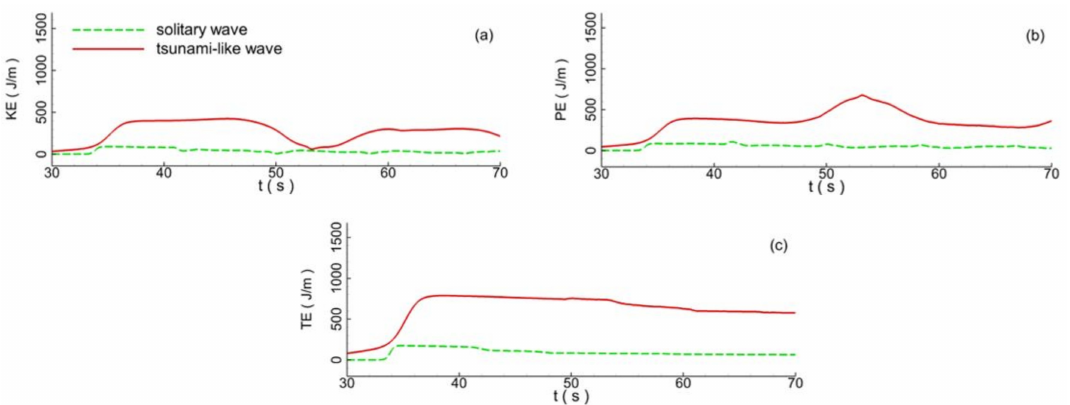
Figure 15. Comparisons of the temporal evolutions of wave energies of the whole water body in the computational domain; ( a ) KE ; ( b ) PE ; ( c ) TE .